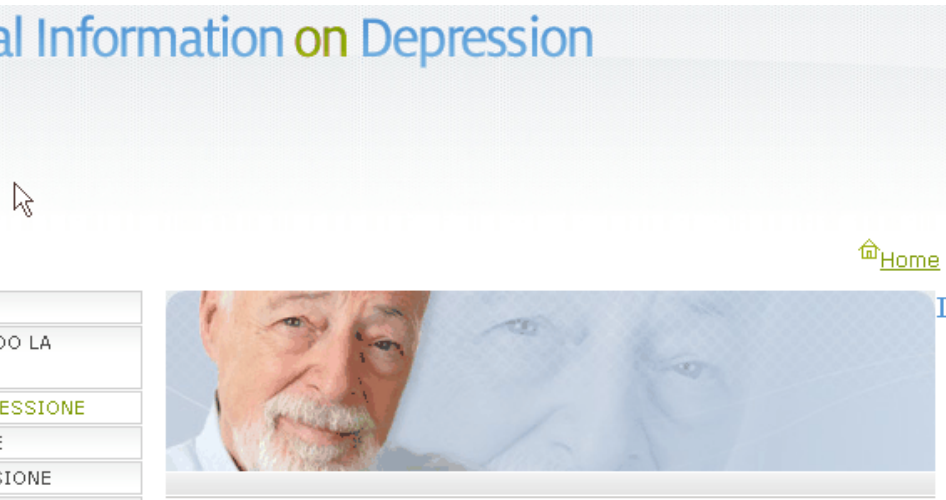
Figure 2. Screenshot of the MIDonline website in